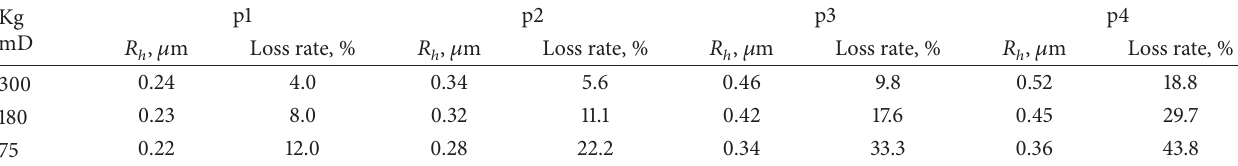
Table 3: Changes in the hydrodynamic dimensions of the produced liquid from polymer